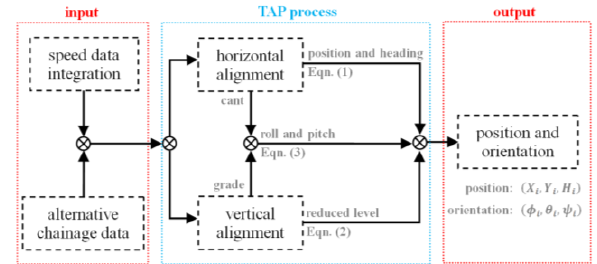
Figure 1. Flow chart for Track Alignment